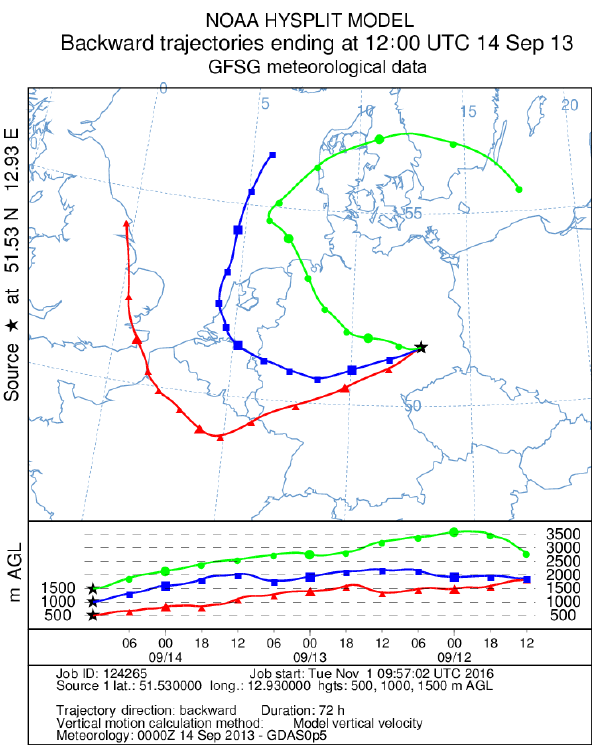
Figure 6. Three 72h backward trajectories for 500 (red), 1000 (blue), and 1500m (green) aboveground for Melpitz, ending at 27 September,